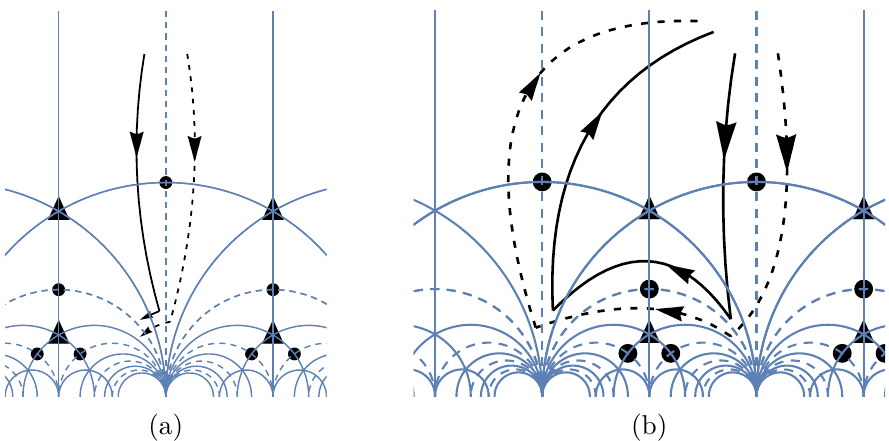
Figure 2 . The paths ˜ γ ˜ g are drawn in the complex t plane in (a) by the solid and dashed oriented lines, respectively. In the panel (b), the solid and dashed oriented lines are the paths (loops in fact) for (˜ g 3 ) 3 and (˜ g 0 respectively. For more information, see the caption of figure